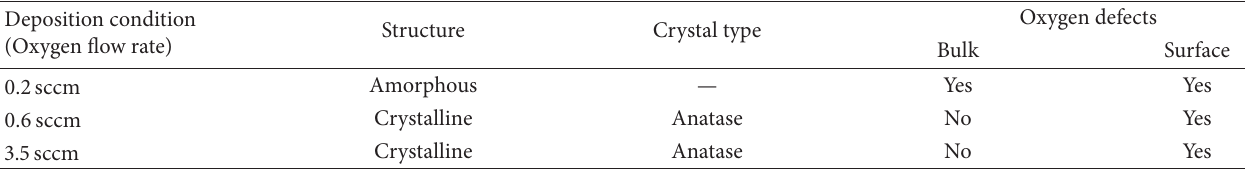
Table 1: Structural properties of the